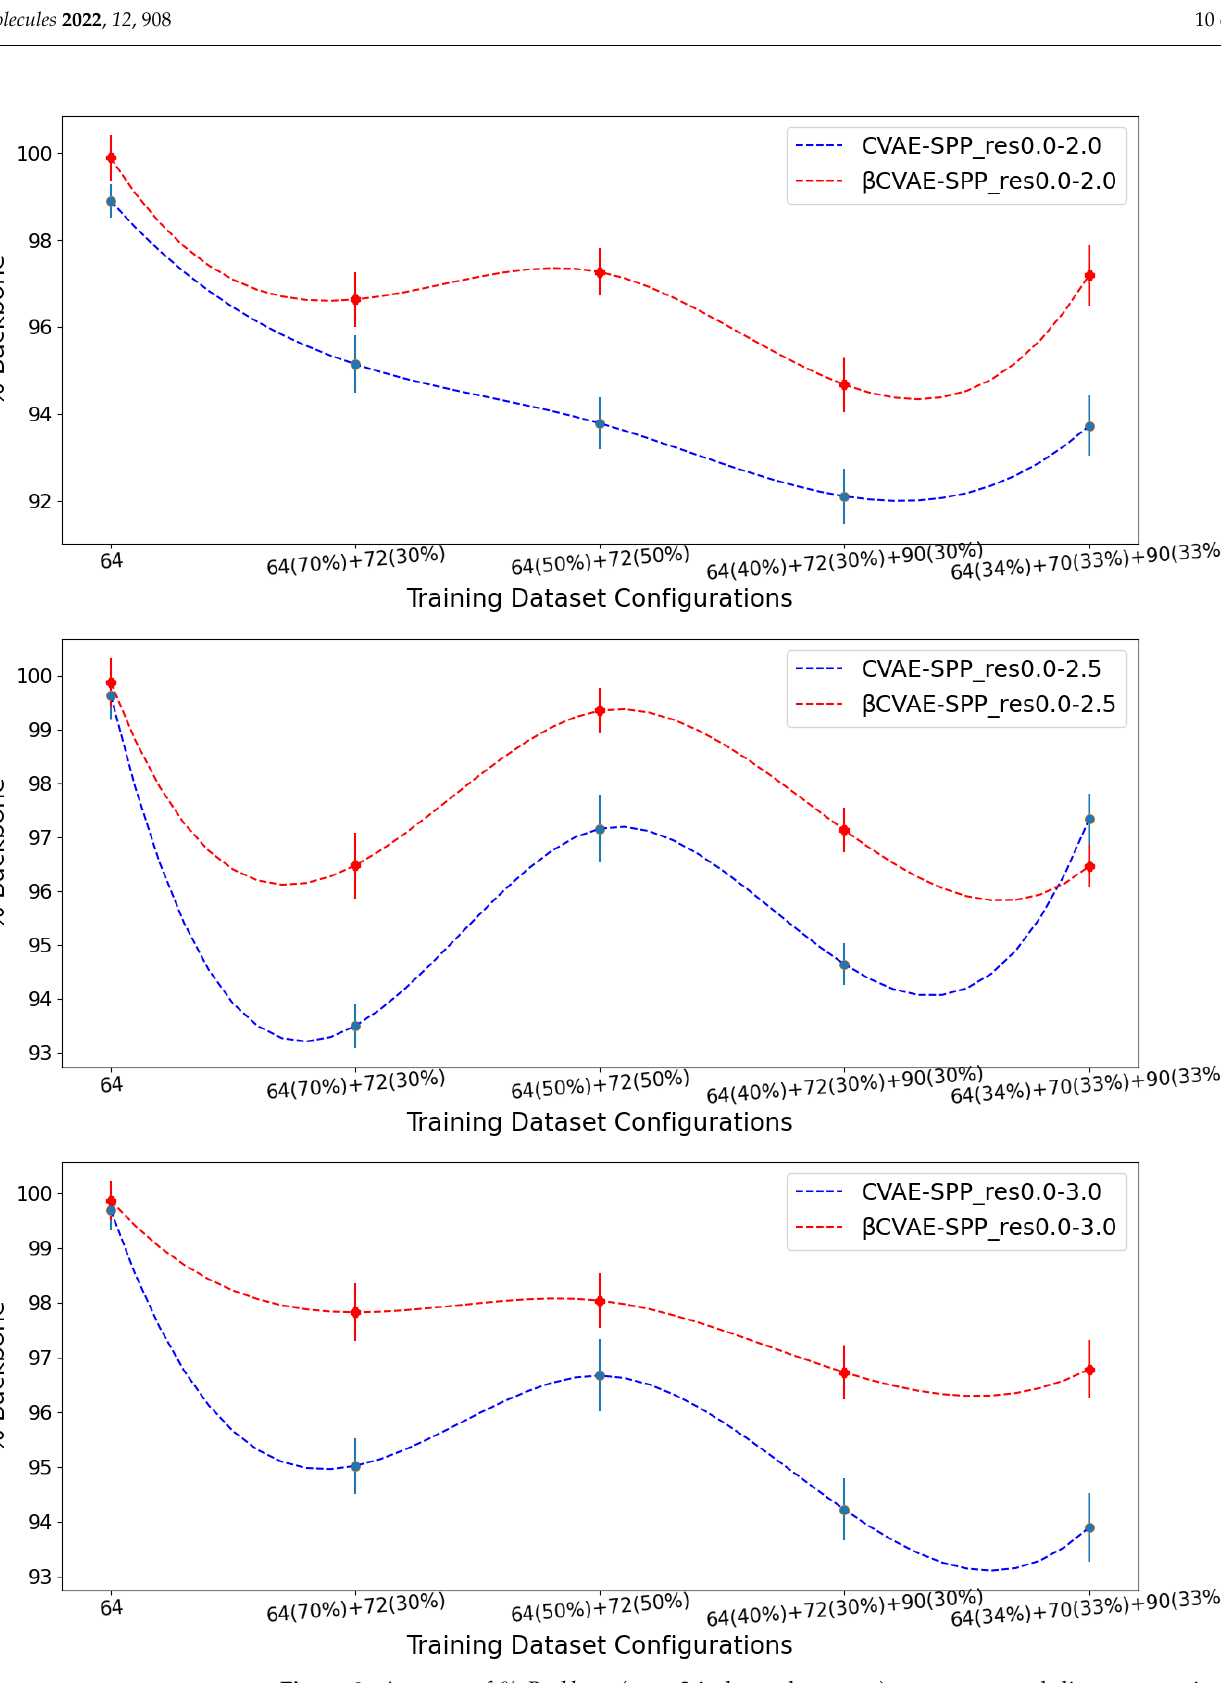
Figure 3. Average of % Backbone (over 3 independent runs) over generated distance matrices by CVAE-SPP and β CVAE-SPP. Each model is trained on a training dataset configuration ( x -axis) of an input dataset. The three panels relate the different input